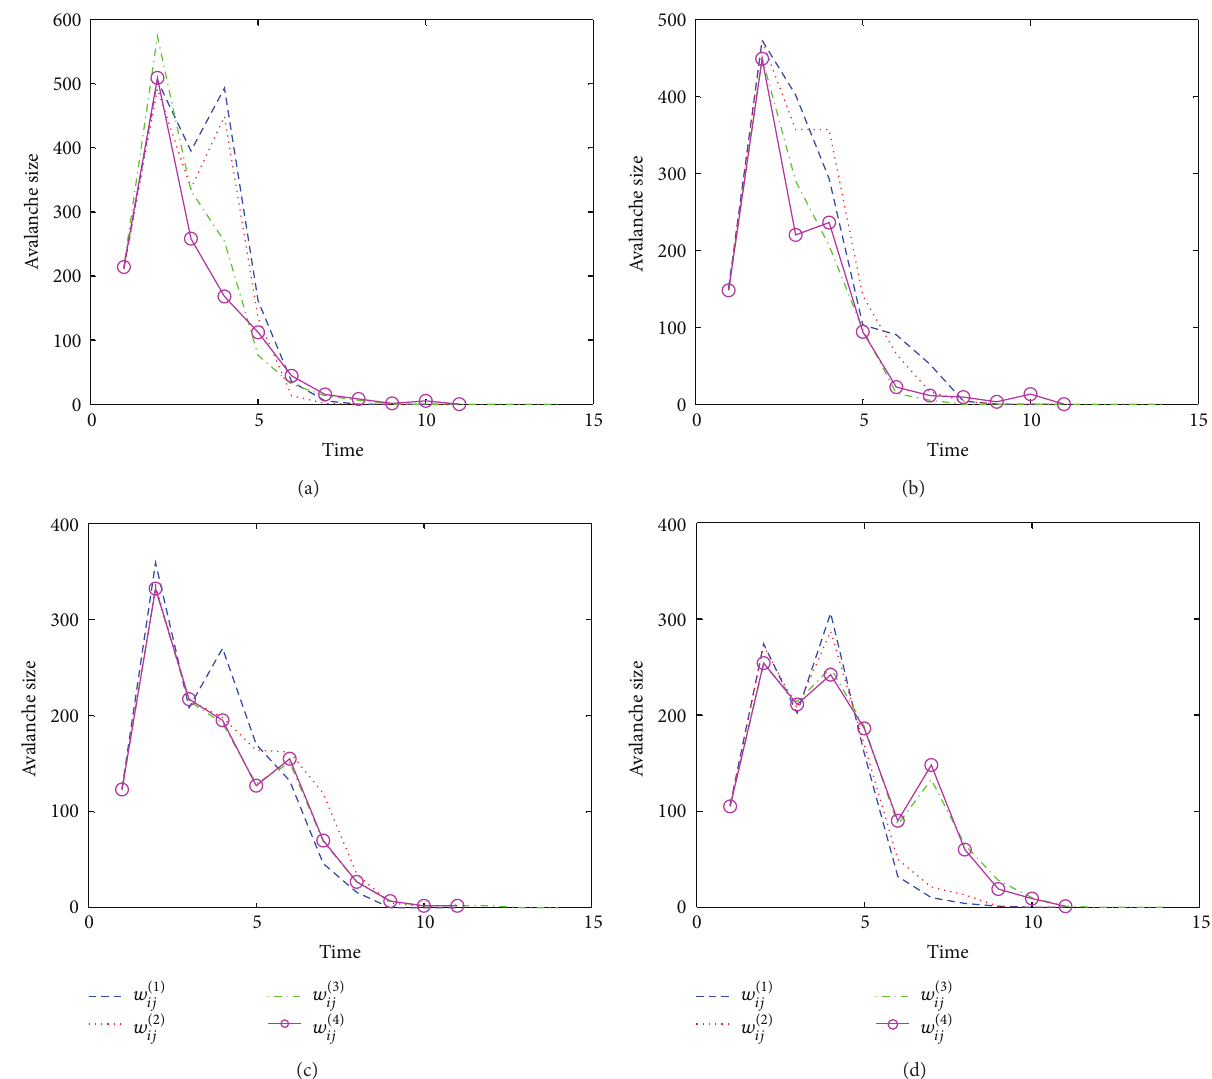
(𝑡) in each time step 𝑡 as a function of 𝑡 for ae